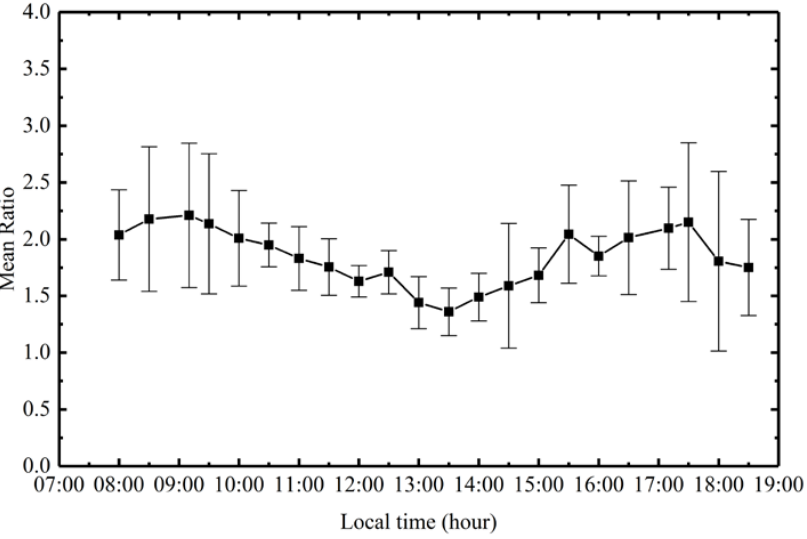
Figure 8. Diurnal variation of ECO Chl-a and lab fluorometric Chl-a ratio.